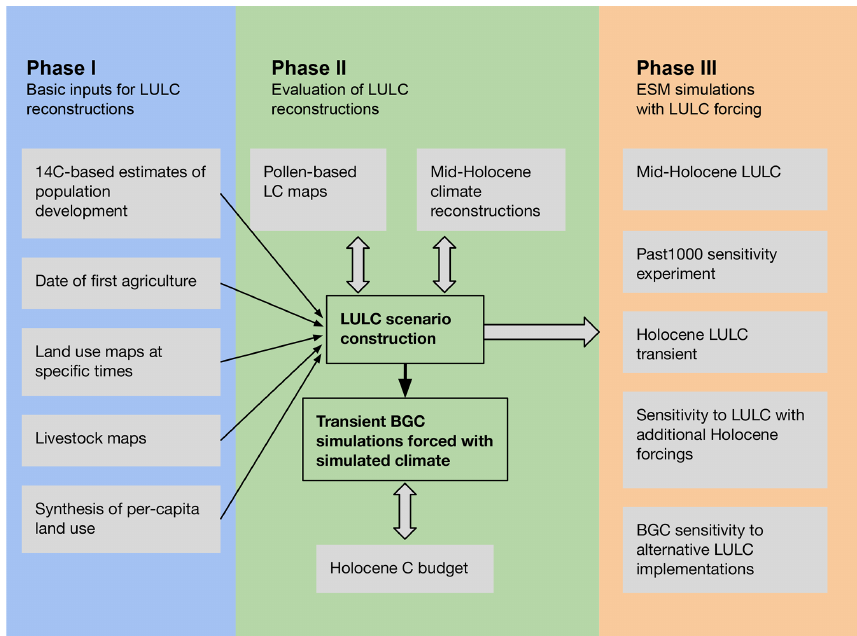
Figure 2. Proposed scheme for developing robust LULC scenarios through iterative testing and refinement as input to Earth system model (ESM) simulations. The archaeological inputs developed in phase 1 can be used independently or together to improve the LULC reconstructions; iterative testing of the LULC scenario reconstruction (phase 2) will ensure that these inputs are reliable before they are used for ESM simulations (phase 3). The uppermost three LULC simulations capitalize on already planned baseline simulations without LULC; the lowermost two simulations are envisaged as new sensitivity